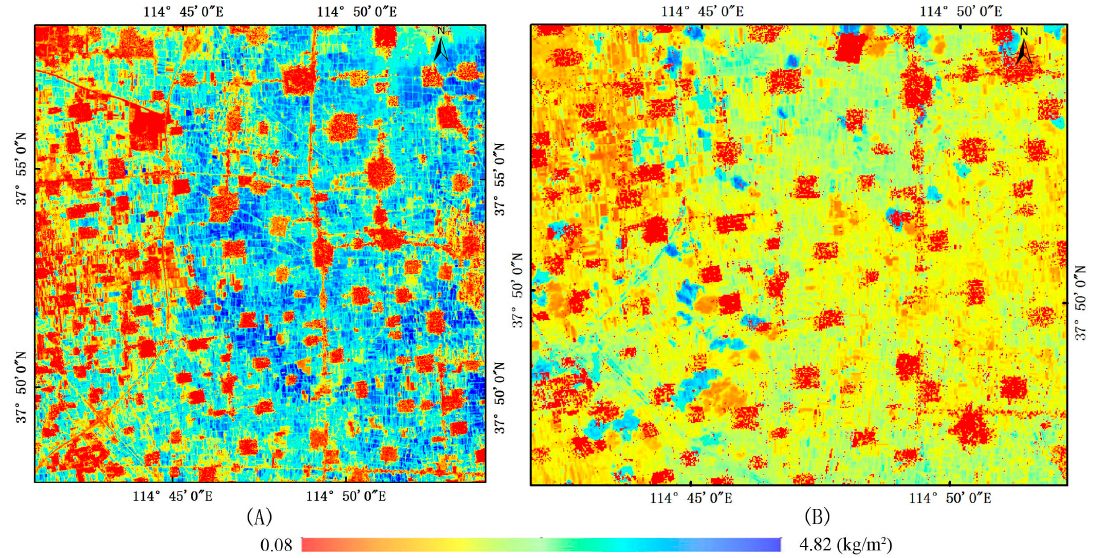
Figure 5. VWC derived from Landsat-8 OLI data (kg m − 2 ) (( A ) wheat in the filling stage, ( B ) corn in jointing stage).